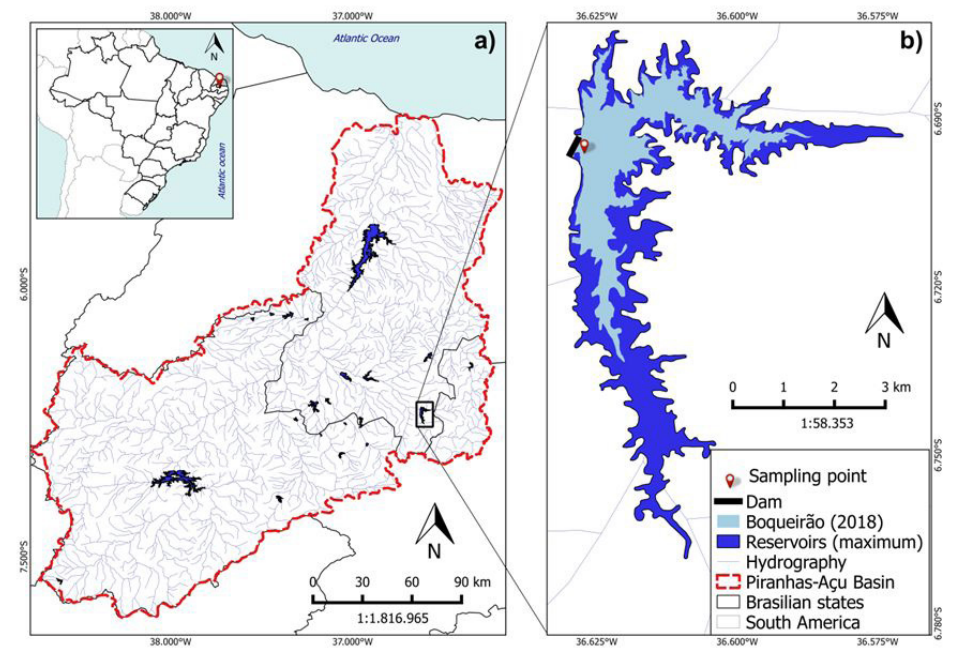
Figure 1. Study area: a) Piranhas-Açu watershed and b) Boqueirão de Parelhas reservoir, with the sampling station (red and white point) near the dam (black stroke). The surface area in 2018 is illustrated by the light blue area in the figure b and was determined through a Google Earth image from October 2018. The dark blue area represents the maximum surface area that is reached when the reservoirs reaches its maximum